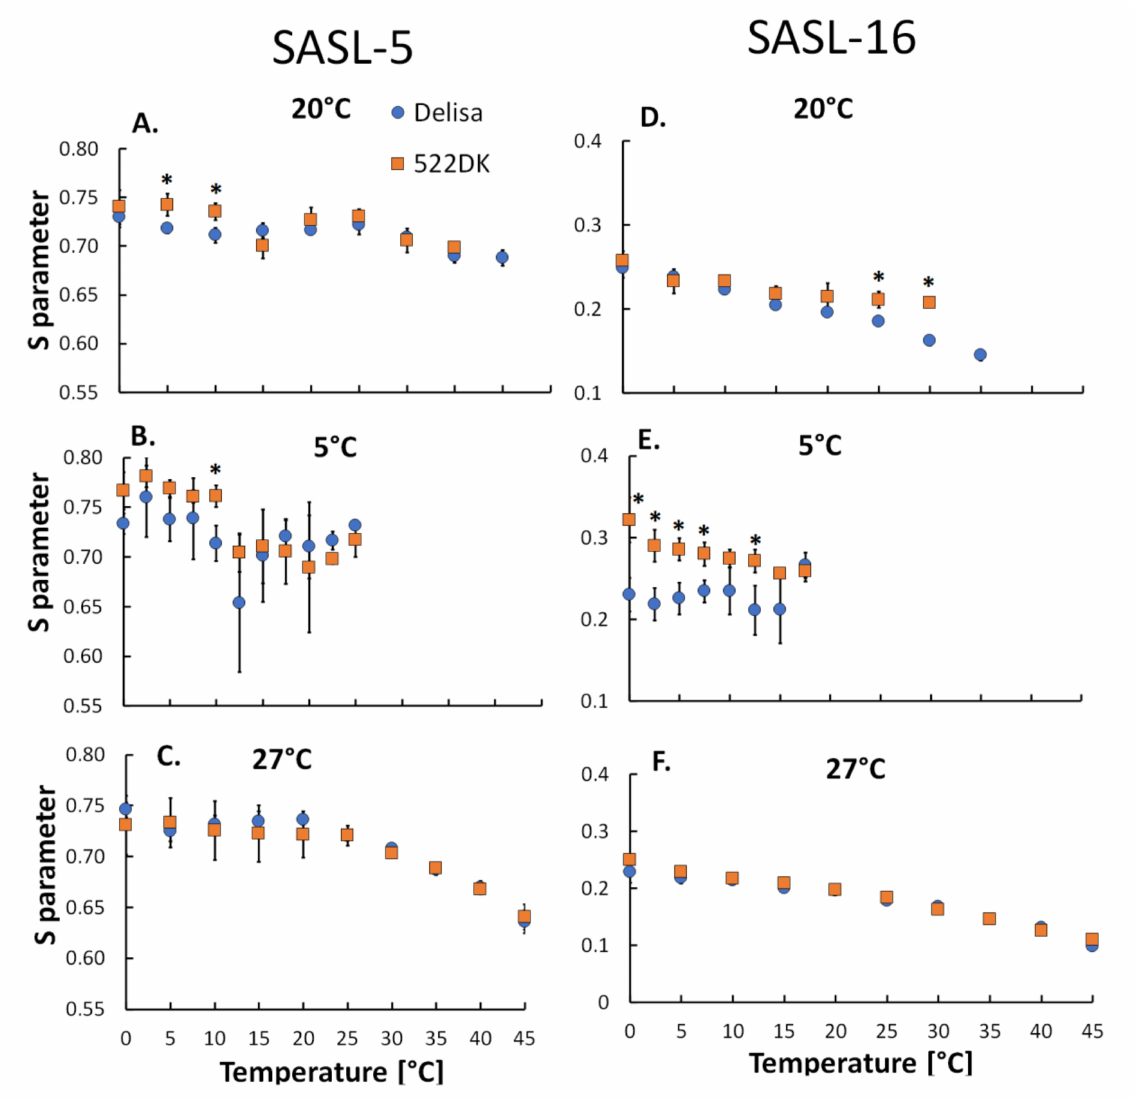
Figure 4. Dependence of the dynamic orientational order parameter S that was calculated for the chloroplast membranes that had been isolated from the barley wild-type Delisa and its mutant 522DK with incorporated SASL-5 ( A – C ) and SASL-16 ( D – F ) on temperature. Plants had been cultivated at 20 ◦ C and acclimated at 5 ◦ C and 27 ◦ C. Average data are given ± SE and significant differences between the wild type and mutant are indicated with an asterisk (*); comparisons were made separately for each EPR measurement